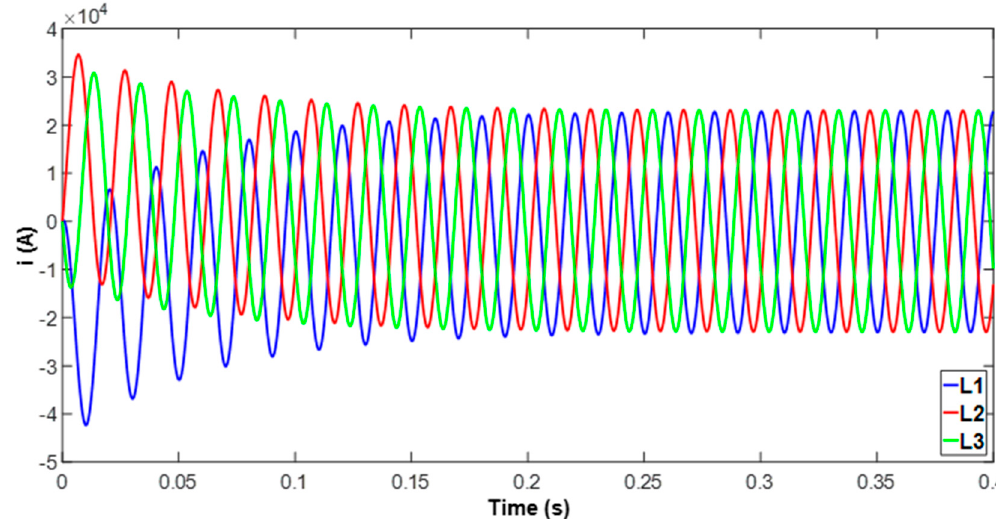
Figure 2. Simulation current for each phase. Table 1. Peak current and short-time r.m.s. current for each phase.